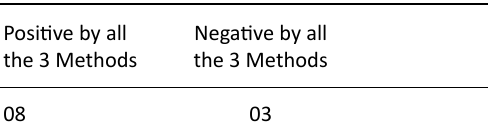
Table 7. Number of Positive and Negative isolates by all the 3